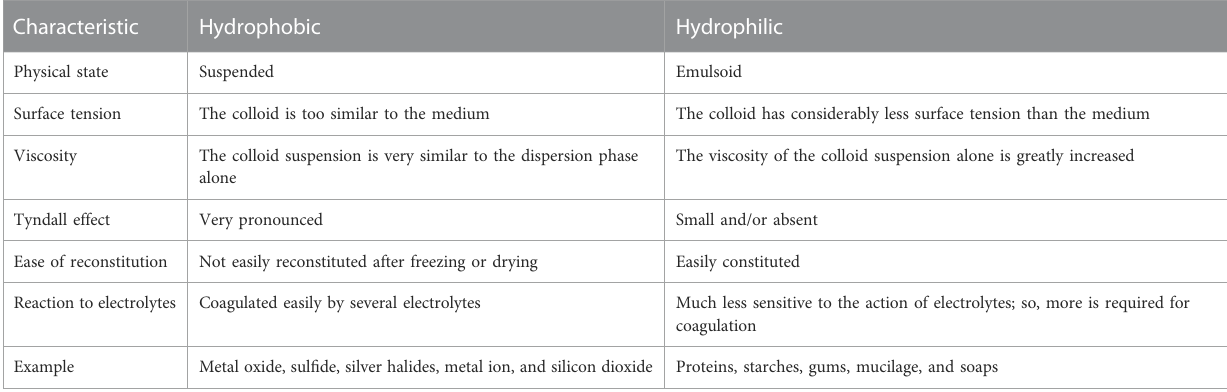
TABLE 1 Type and characteristics of colloidal solids (Kingsley Ogemdi, 2019).